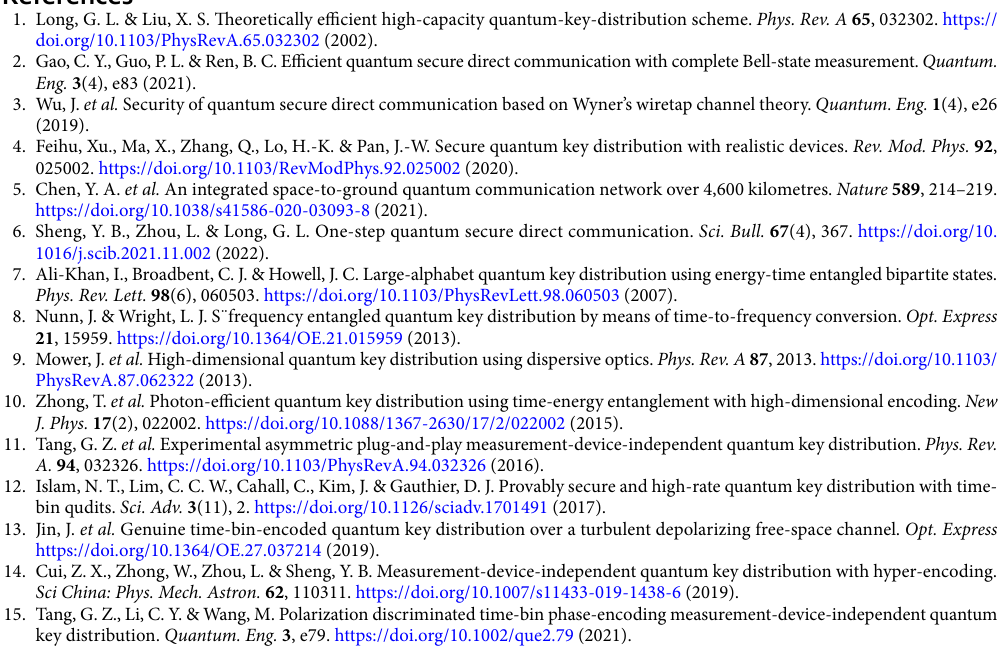
terms of P ≈ 0.3, N = 6000, the standard error according to Eq. (4) can be as low as 5.92 × 10 −3 . The energy level n of quantum state is set between 90 to 140 in compliance with the Eq. (5), and the smallest uncertainty of clock difference we can estimate is about 1.8 × 10 −4 . It’s obvious from Fig. 3 that the experimental and simulation results